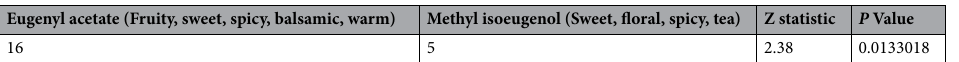
Table 2. Duo trio sensory test result between eugenyl acetate (17,8 neuron) and methyl isoeugenol (18,7 neuron)-cinnamaldehyde (17,8 neuron) as a reference sample.